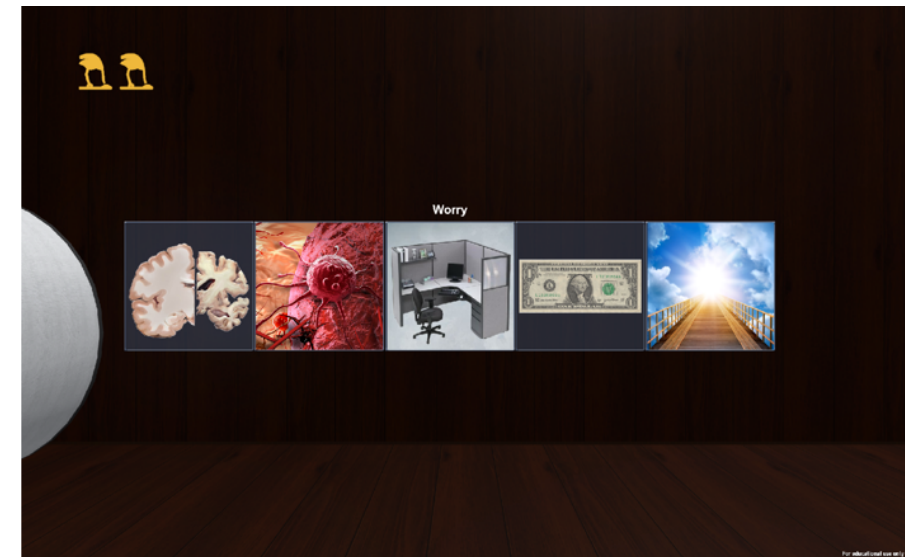
Figure 11. Still from Psychasthenia 3: Dupes . Courtesy of the